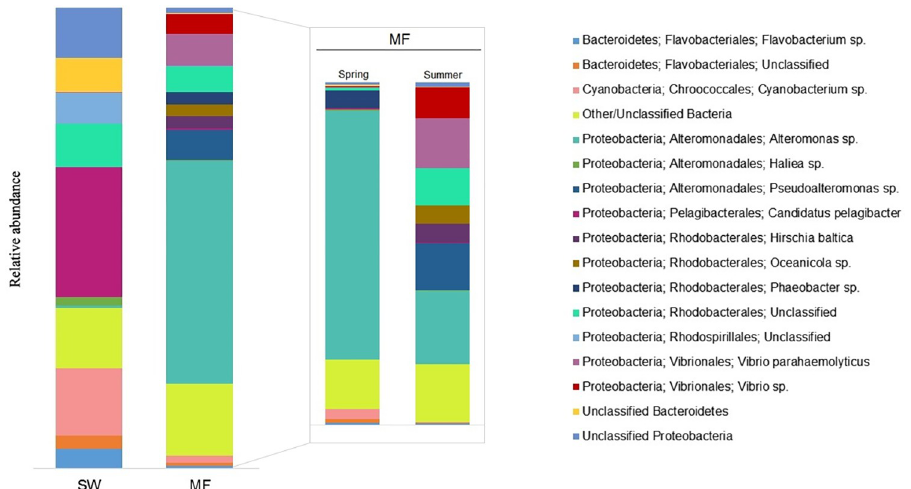
Fig 5. Bar chart showing taxonomic composition and dominance of a relatively small number of abundant OTUs, for seawater (SW) and floating microfibers (MF) in the Mediterranean Sea. Similarities between microfibers collected during spring and summer seasons are detailed. For more clarity, OTUs representing less than 1% or unclassified at the class level are grouped in the Other/Unknown series.